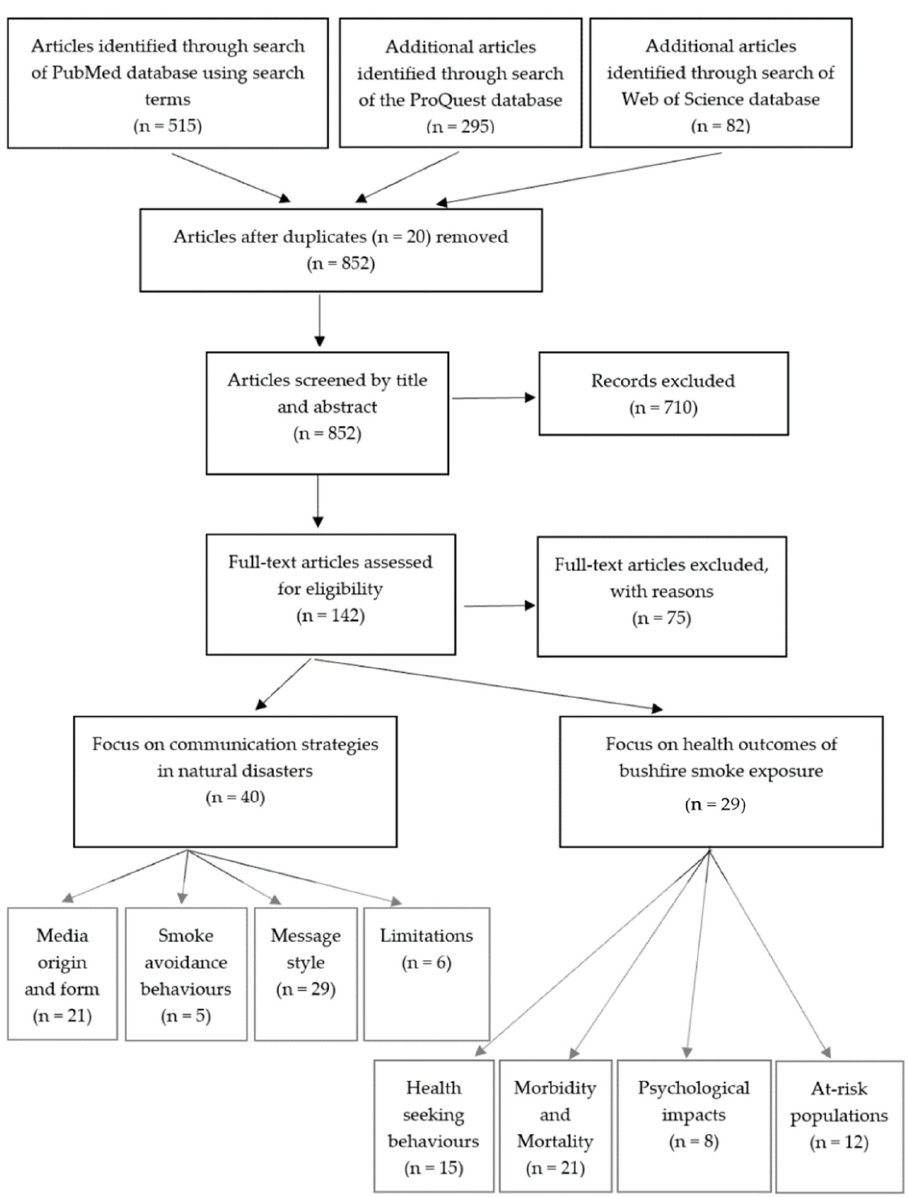
Figure 1. Selection of articles from the initial identification stage to abstract and full text screening before categorising into subsections for content analysis. Two of the included articles covered both communication strategies and health outcomes of bushfire smoke exposure.